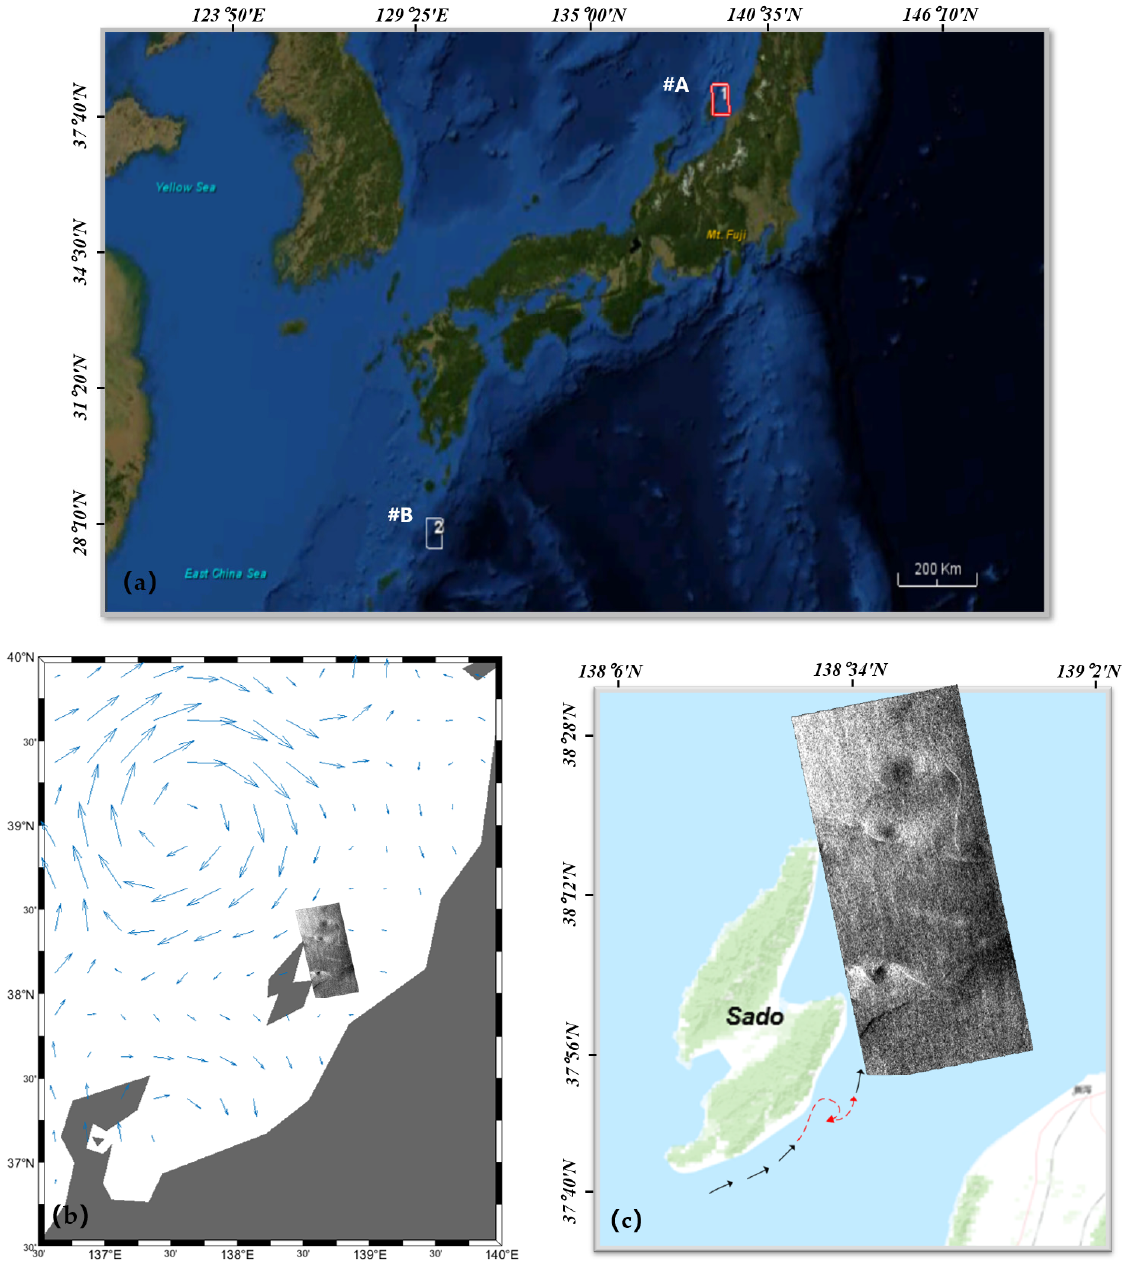
Figure 2. Location of the image acquisition. ( a ) Data acquisition region. ( b ) Snapshot of the surface velocity field (vectors) gridded at 1/3°, derived from OSCAR on 11 November 2010. ( c ) Inference for the formation mechanism of the “white” eddy in data #A. The black arrow is the direction of the current, and the red dashed arrow is where the eddy is formed. Table 1. Image details.